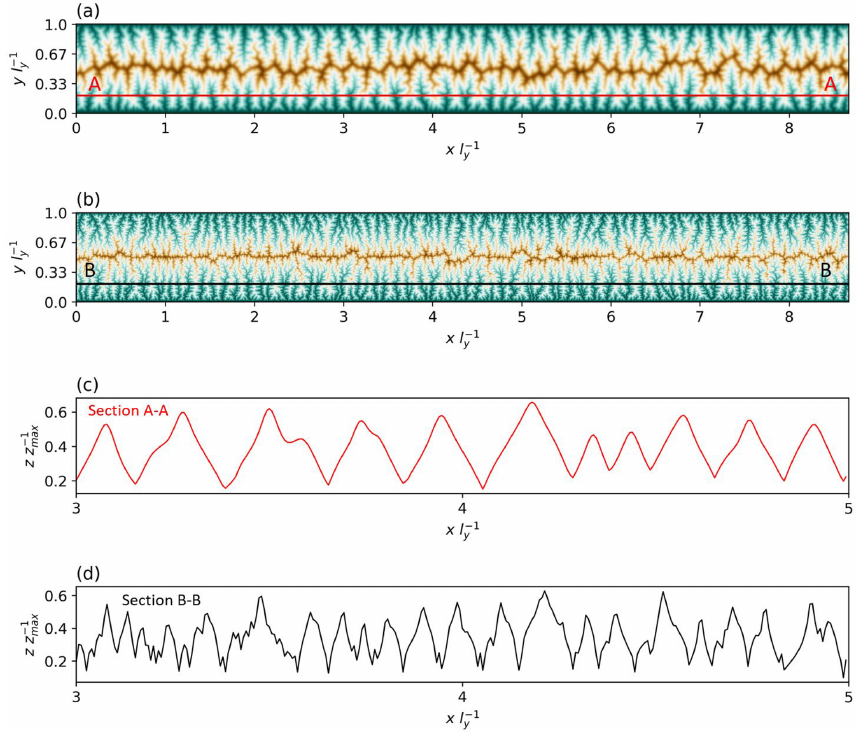
Figure 5. Steady-state simulation of landscape elevation given by Eqs. (27) and (28) for m = 0 . 5 and different channelization indices, Eq. (33), C I = 10 3 in (a) and C I = 10 4 in (b) . The elevation along A–A and B–B transects is shown in (c) and (d) . After Hooshyar et al.